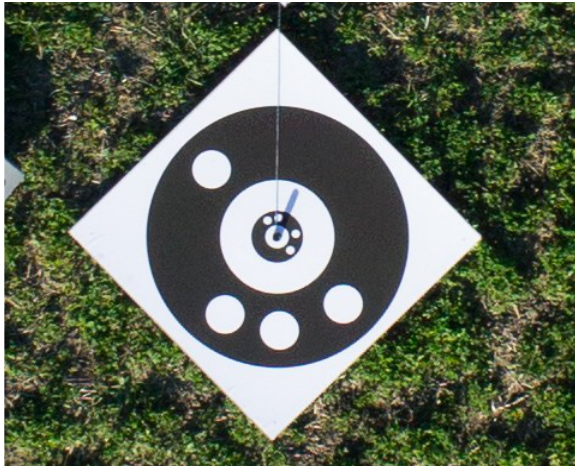
Figure 3: Optical target in mapKITE, observed from 10 m flight height using a Sony NEX-5 camera with 16 mm lens.